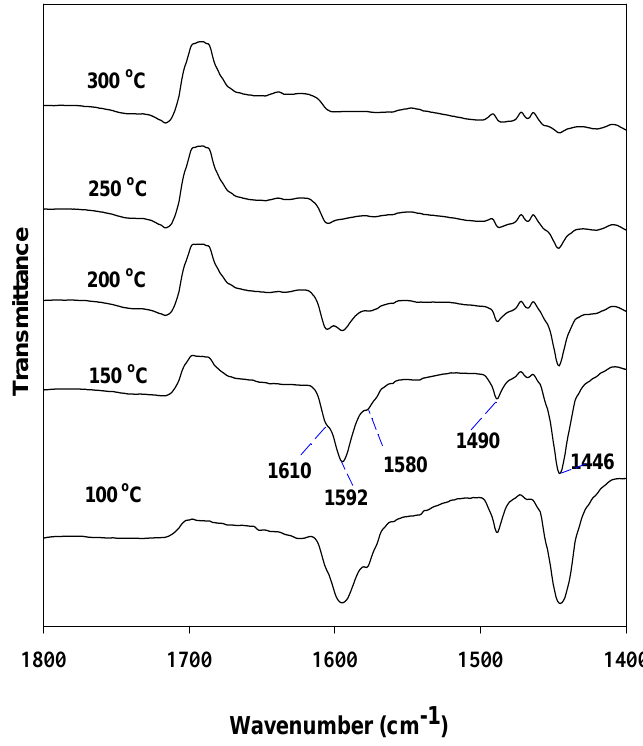
Figure 5. FT-IR of adsorbed pyridine over V was desorbed under 10 − 3 torr at 100, 150, 200, 250, and 300 °C.